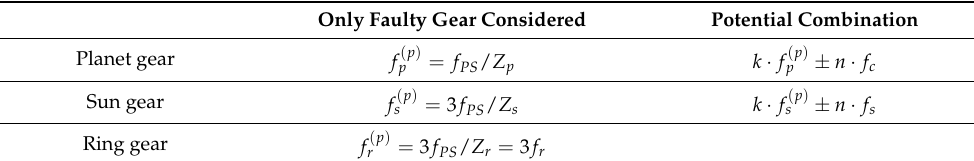
Table 5. Fault characteristic frequency of planetary gear transmission.